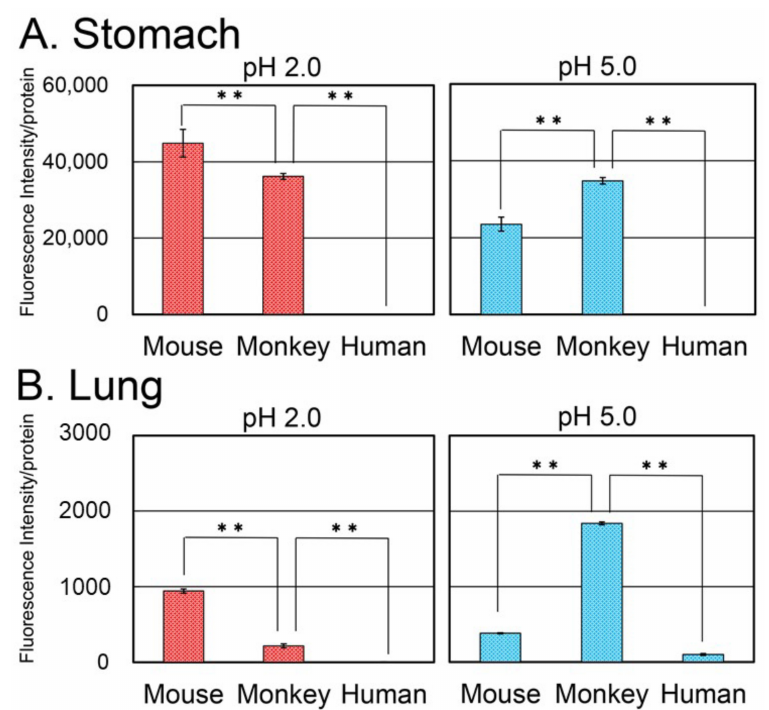
Figure 7. Chitinolytic activity in mouse, monkey, and human ( A ) stomach and ( B ) lung tissues. The activity was measured using a fluorogenic chitin substrate, 4-MU-chitobioside. Chitinolytic activity at pH 2.0 or pH 5.0 is expressed on the y -axis: red bars, pH 2.0; blue bars, pH 5.0. Fluorescence intensity is shown as activity per 16 µ g protein. ** p <